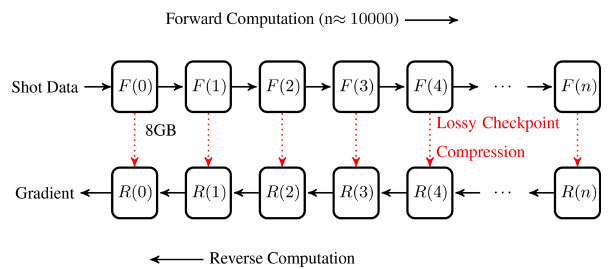
Figure 1. An illustration of the approach presented in this paper. Checkpoints are compressed using lossy compression to combine lossy compression and the checkpoint-recompute